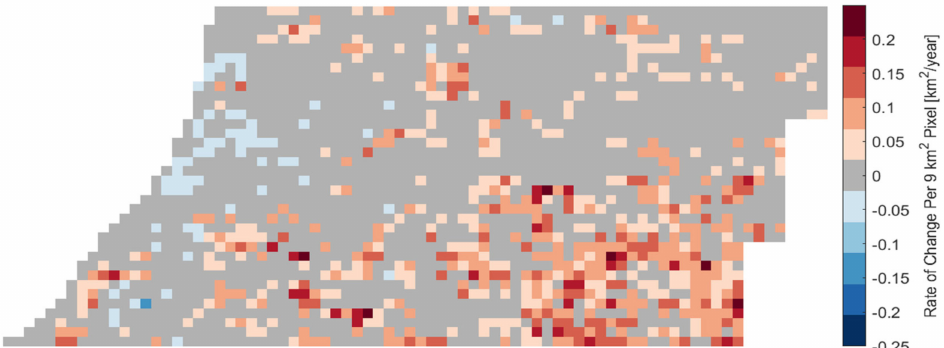
Figure 8. Rate of change of irrigated area over time based on linear regression calculated for an aggregated 9 km 2 grid. Gray indicates non-significant trend ( α > 0.1).